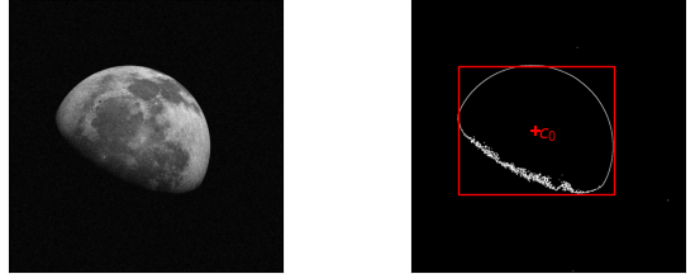
Figure 1. Output of the first step of the pipeline. The detected bounding box is a first crude estimation of the target centroid c 0 .